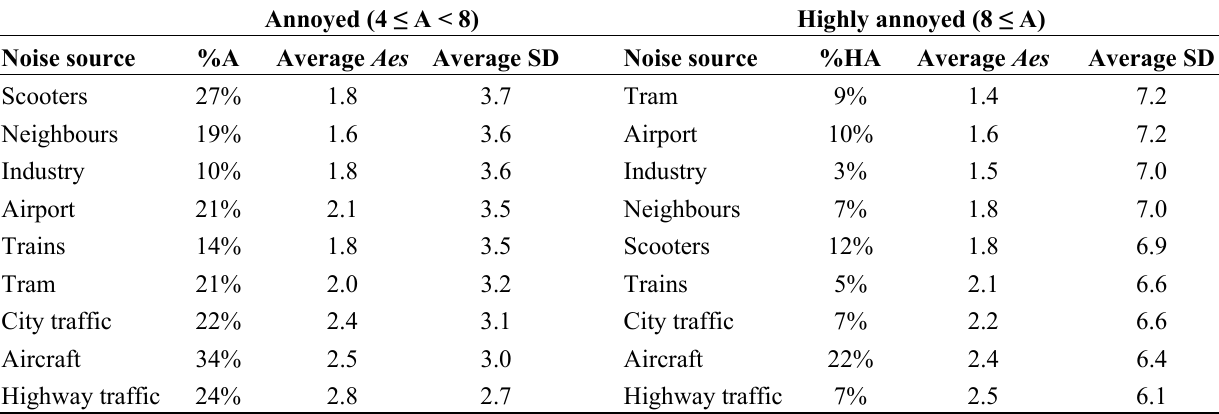
Table 3. Scoring characteristics of respondents that can hear source, separated in two annoyance ranges (annoyed and highly annoyed). Shown for each range: percentage of average sleep disturbance score (SD). Ordered according to average SD score, separately for both annoyance